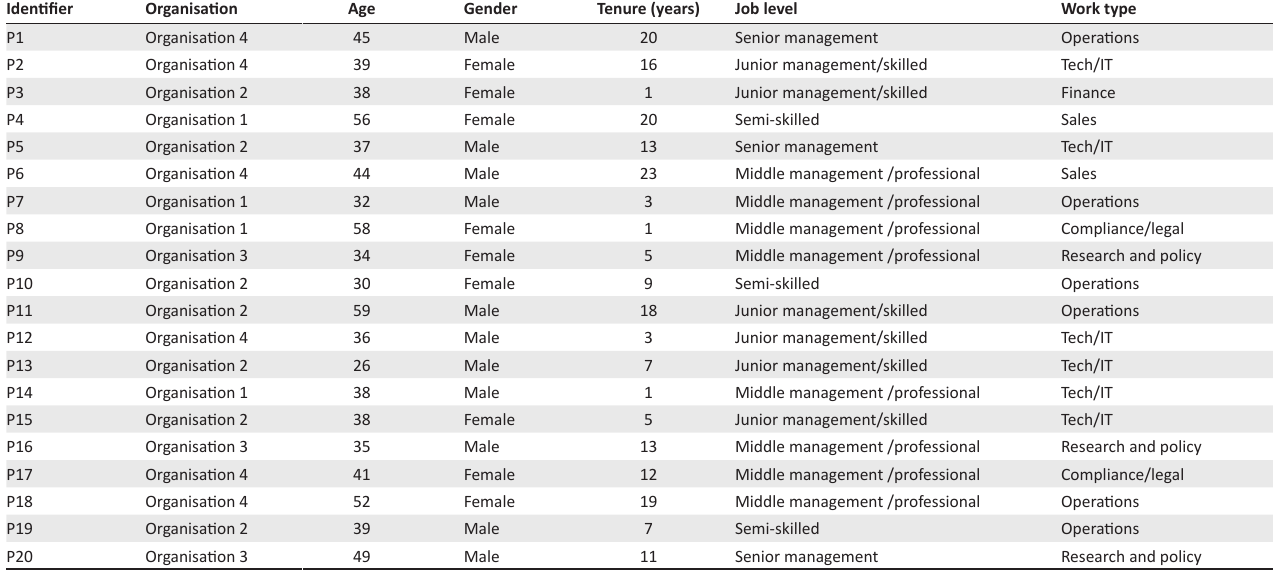
TABLE 1: Interview participants’ demographic